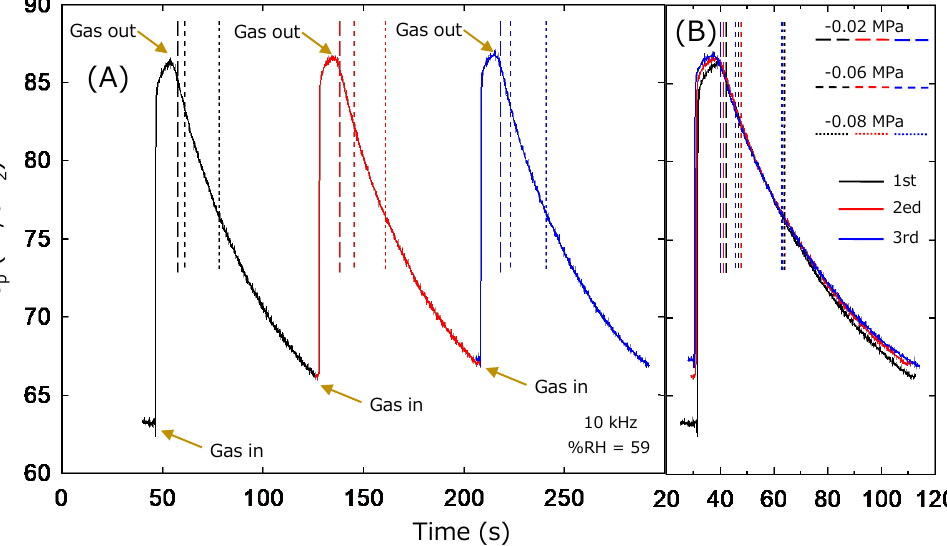
Figure 8. Repeatability of the C p of ZnAl 2 O 4 /Al device against changing pressure between the vacuumed state as %RH = 0 and normal atmosphere as %RH = 59. ( A ) C p is plotted against absolute time. ( B ) C p is plotted against the relative time of each cycle.